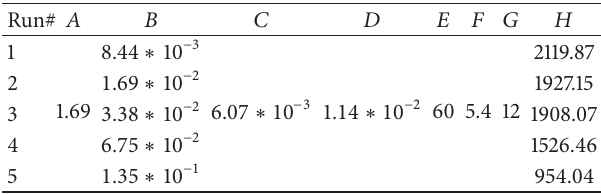
Table 6: Reactions conditions with different surfmer concentra- tions.